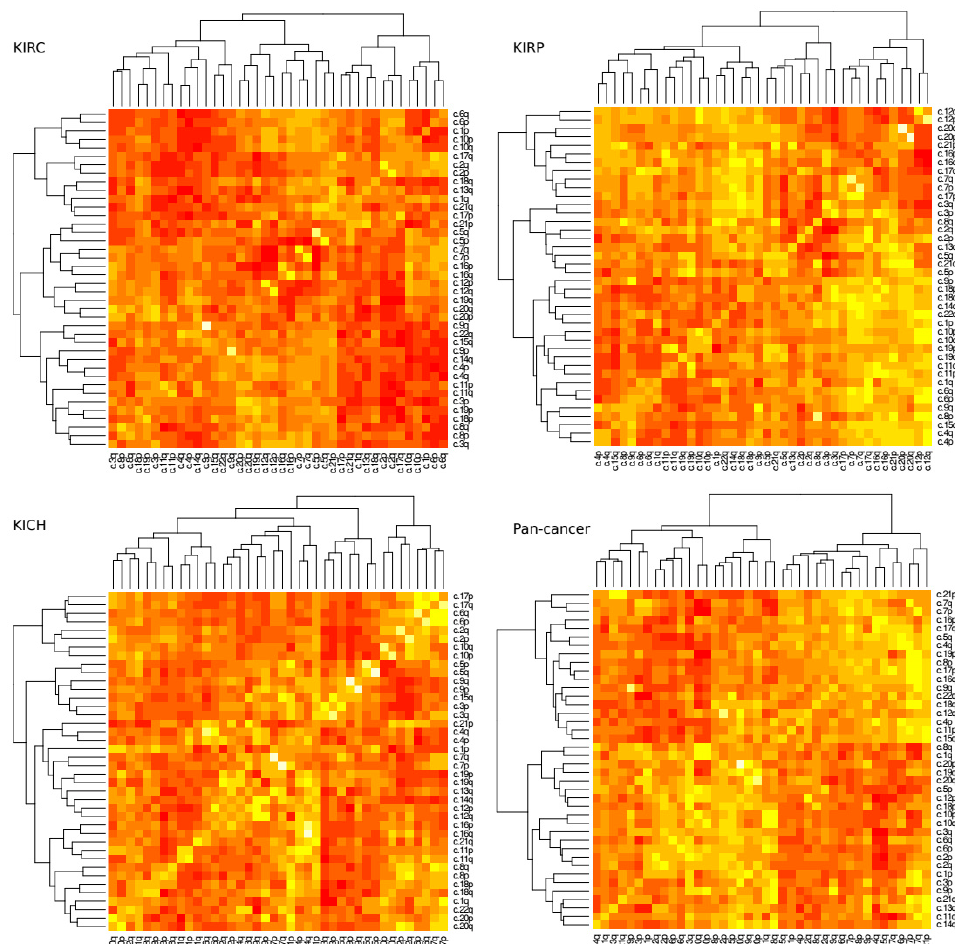
Figure 3. Arm ploidy correlational heat maps. Taking the Pearson correlation coe ffi cient as our measure, we visualise the correlation of gain and loss of copy number for each chromosome arm pair in each of our kidney datasets and in our pan-cancer data. Bright yellow tiles denote highly positive correlation and dark red tiles denote highly negative correlations. The results along the diagonal (which report, for example, of the correlation of c.1p–c.1p) are normalised to r = 0 to improve overall contrast).